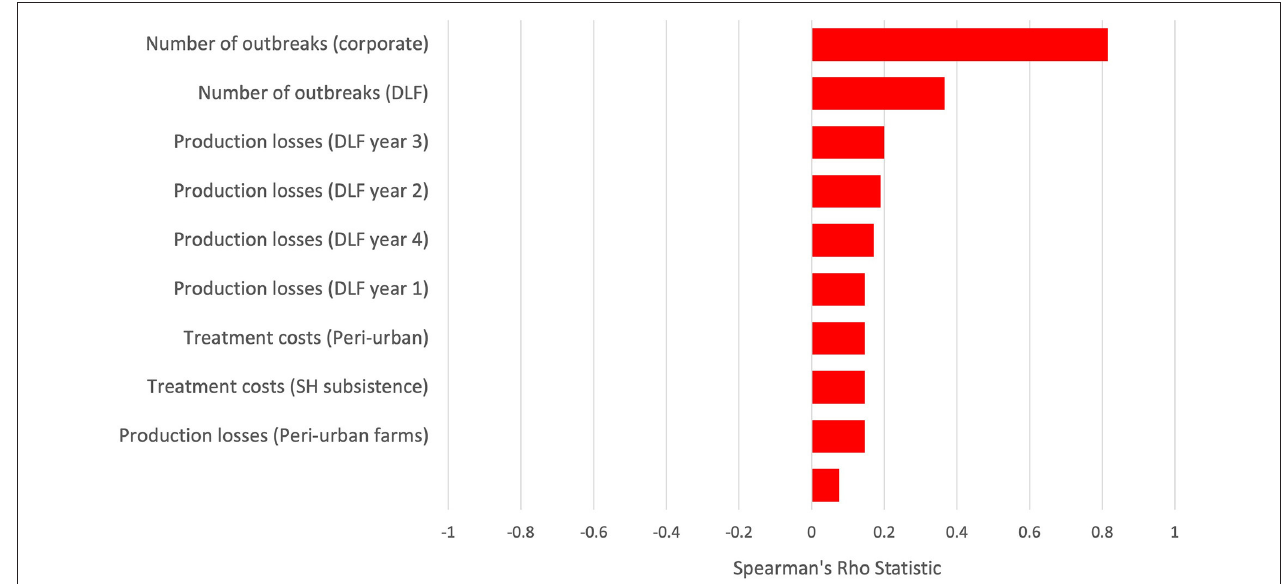
FIGURE 4 | Sensitivity analysis–tornado plot demonstrating the top 10 variables affecting the results of the cost–benefit